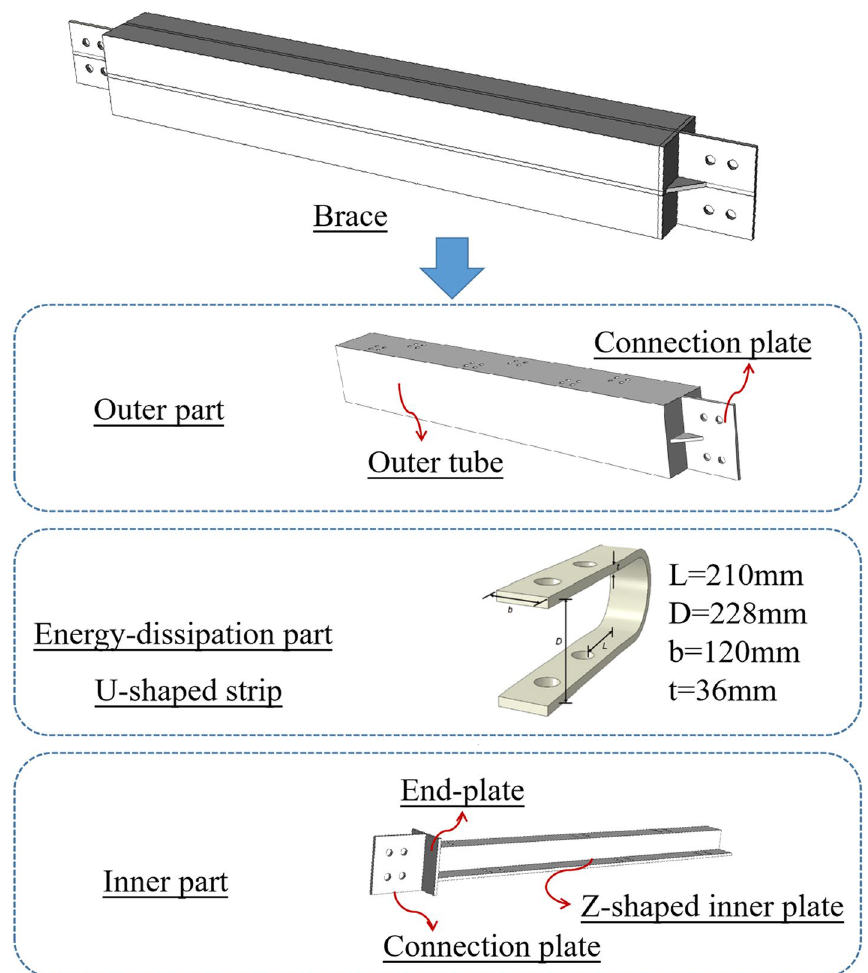
Fig. 16 Three‑dimensional schematic illustration of